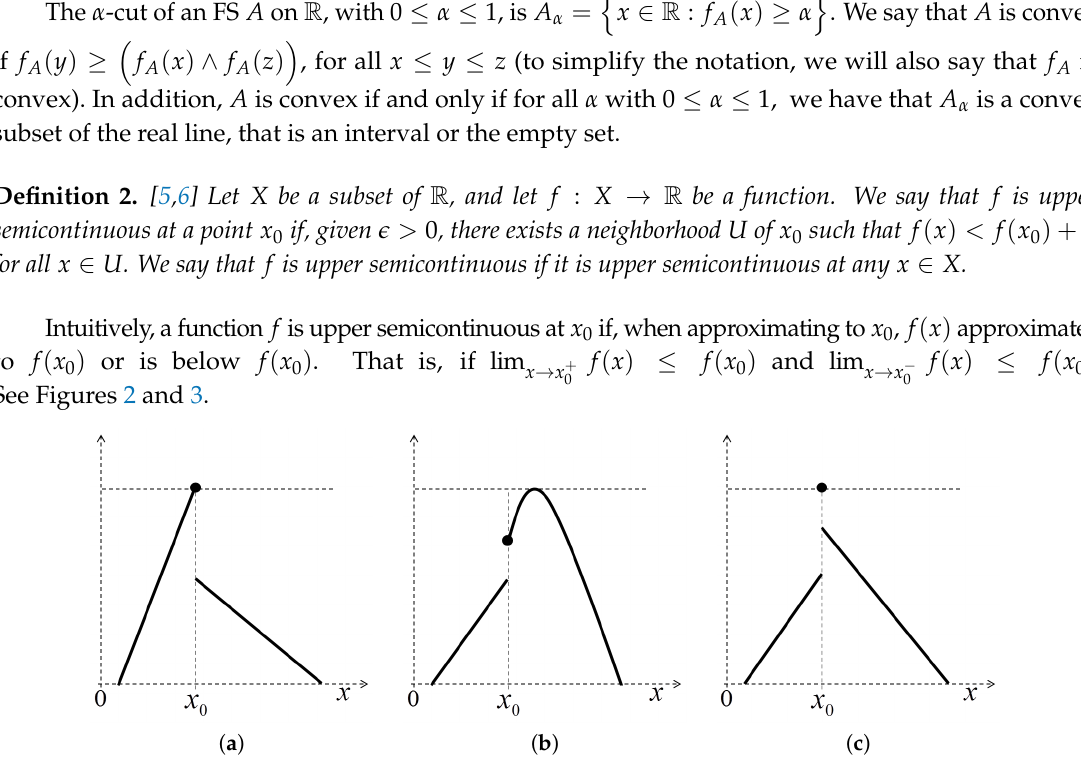
Figure 2. Upper semicontinuous functions: ( a ) Discontinuous from the right; ( b ) Discontinuous from the left; ( c ) Discontinuous from the right and from the